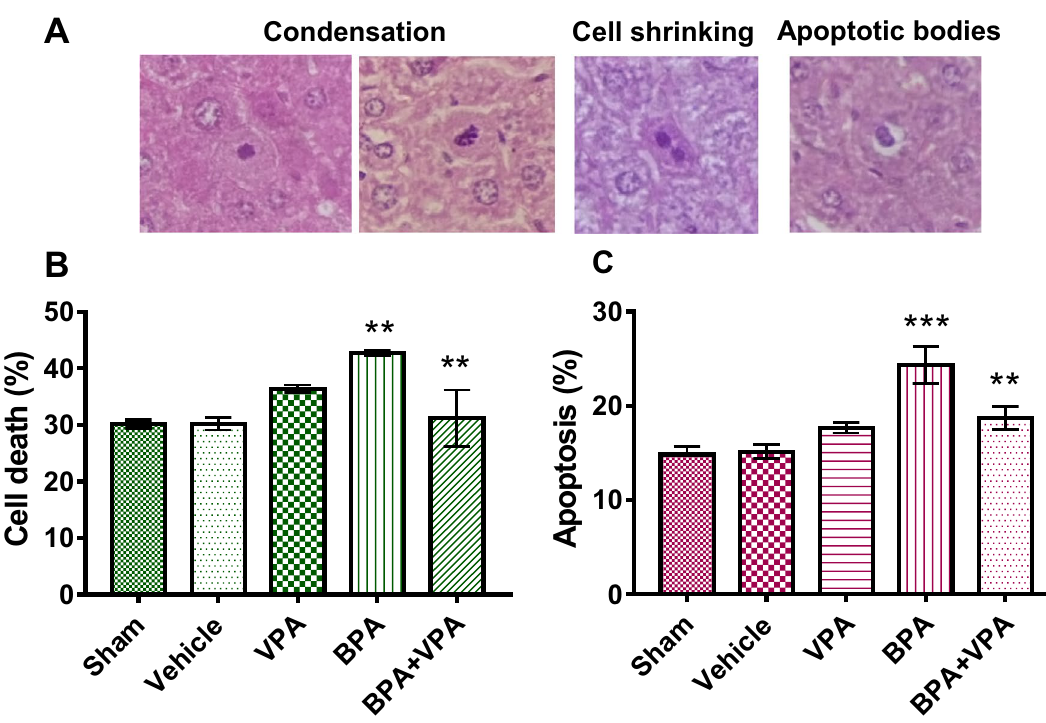
Figure 4. VPA minimizes hepatocellular apoptosis in BPA-exposed mice. ( A ) Representative photomicrographs of H&E-stained liver tissue sections. Morphological microscopic patterns of delayed nuclear condensation, fragmentation, and apoptotic bodies, which were used to determine the cell death profile in each experimental group. Scale bar = 50 µm; 63 × magnification. ( B ) Quantification of hepatocyte death. ( C ) Quantification of apoptotic hepatocytes with fragmented DNA. Data are represented as the mean ± SEM ( n = 6 per group). ** P < 0.01 and *** P < 0.001. VPA valproic acid, BPA bisphenol A, H&E hematoxylin and eosin, SEM standard error of the